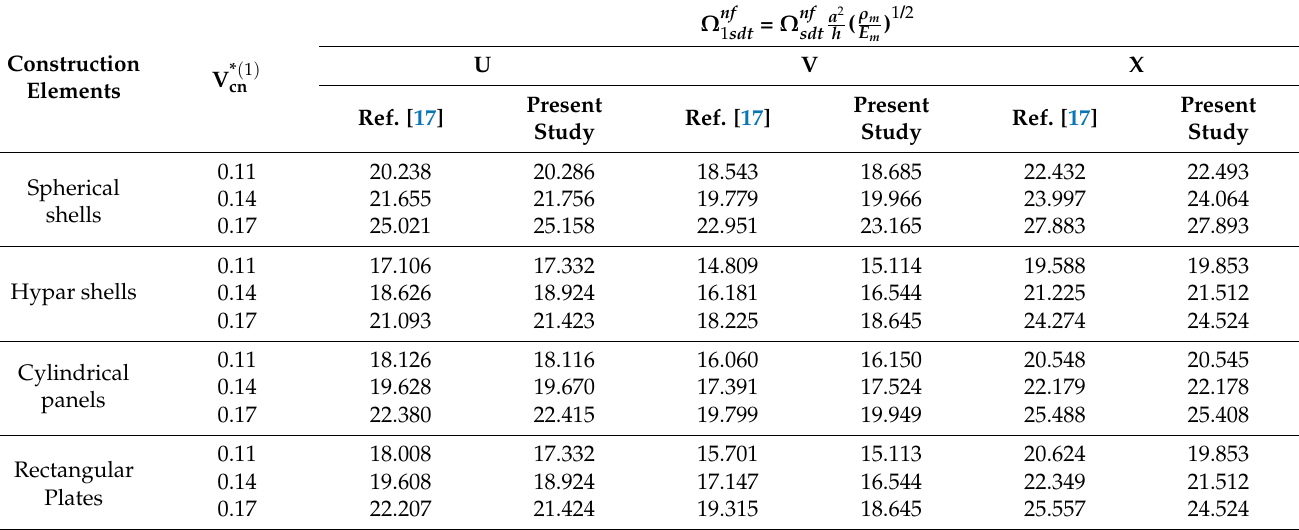
Table 1. Comparison eigenvalues for CNT patterned construction elements with the results of Ref.